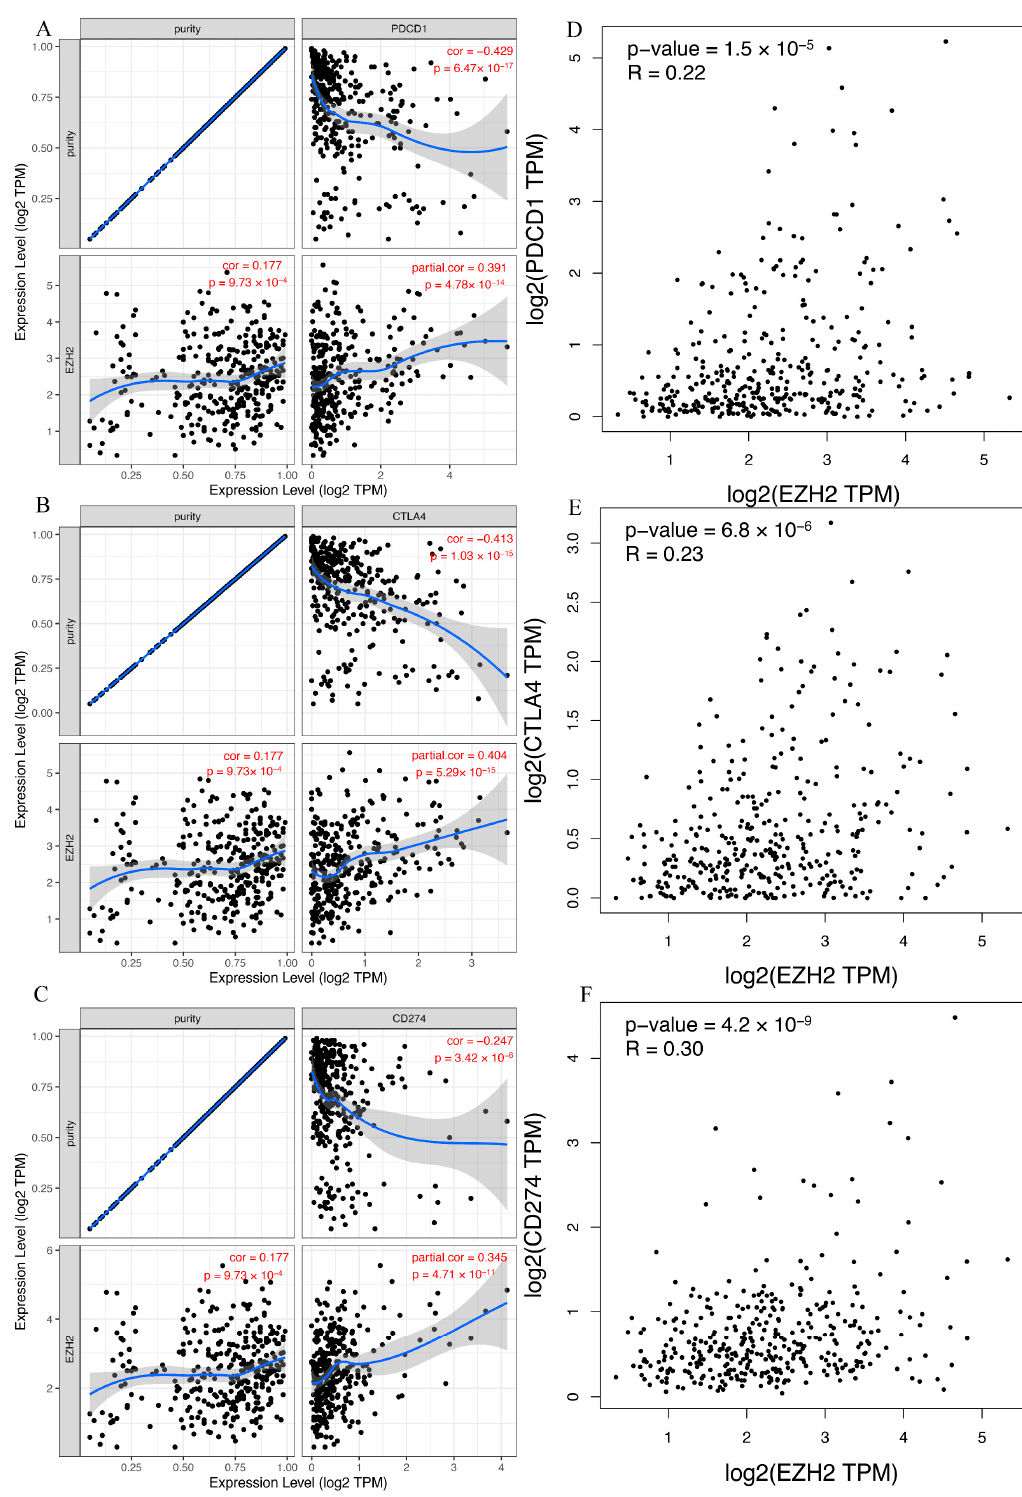
Figure 9. The relationship between EZH2 expression and immune checkpoint genes in HCC. ( A , D ) PDCD1, ( B , E ) CTLA4, and ( C , F ) CD274.